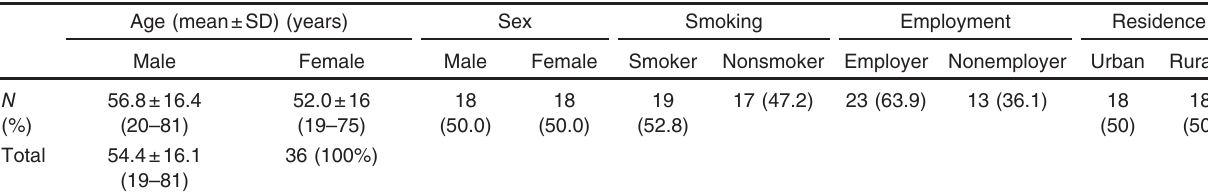
Table 1 Sociodemographic criteria of the studied group